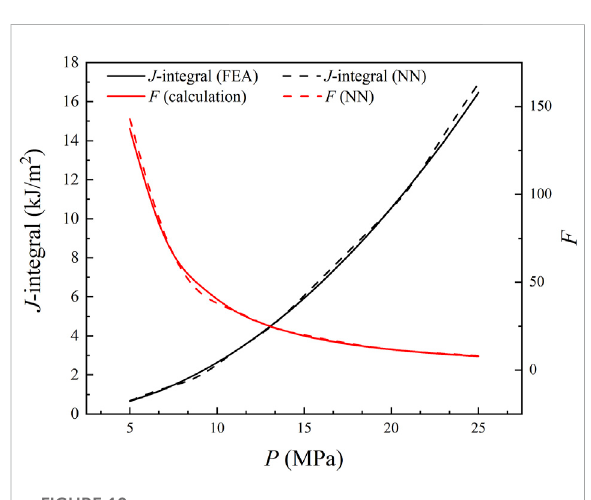
FIGURE 10 Accuracy of predicting unknown characteristic parameters.